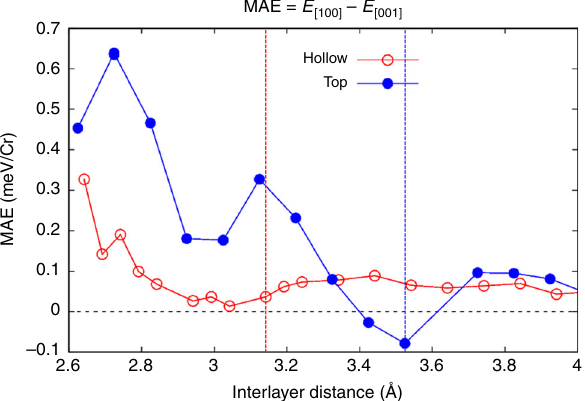
Fig. 3 Calculated magnetocrystalline anisotropy of Cr 2 Ge 2 Te 6 in the heterostructure versus the vdW interlayer distance. Magnetocrystalline anisotropy energy (MAE) (in meV/Cr) of Cr 2 Ge 2 Te 6 as a function of the distance to In 2 Se 3 in the P dn state, showing a gradual increase towards the positive MAE (easy-axis S Cr ) upon decreasing the distance for both hollow and top stacking con fi gurations. This set of calculations con fi rmed the scenario that the enhanced interfacial hybridization between Cr 2 Ge 2 Te 6 and In 2 Se 3 tends to switch the magnetocrystalline anisotropy from easy-plane to easy-axis. The calculation error is re fl ected by the symbol size (~0.01meV/ Cr). The red and blue dashed lines correspond to the equilibrium interfacial distances for hollow and top stacking con fi gurations, respectively